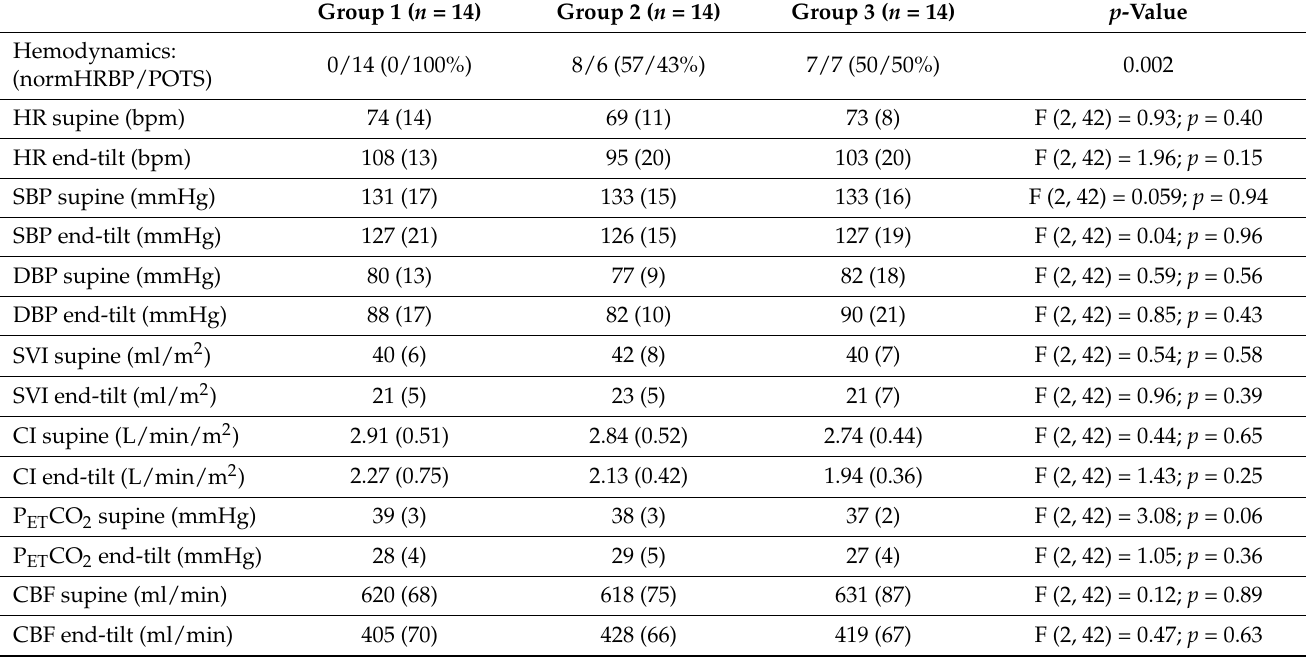
p -values: Chi-square analysis (3 × 2 table) and ordinary one-way ANOVA. HR: heart rate; bpm: beats per minute; SBP: systolic blood pressure; DBD: diastolic blood pressure; SVI: stroke volume index; CI: cardiac index; CB: cerebral blood flow; normHR/BP: patients with a normal heart rate and blood pressure response during the tilt test; POTS; postural orthostatic intolerance syndrome. Upright measurements are the measurements being made just before tilting back. A p -value of <0.01 is considered